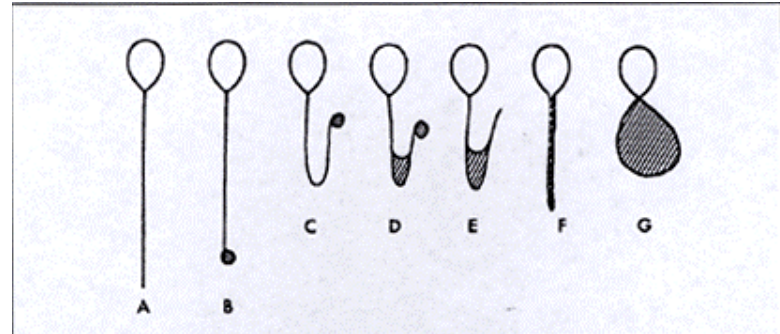
FIGURE 2 . Hypo-osmotic swelling of spermatozoa. Hatched areas indicate swelling. A, no tail swelling and an abnormal response. B-G, various types of tail swelling and a normal response. (From Jeyendran RS, et al: J. Reprod. Fertil., 70:219,